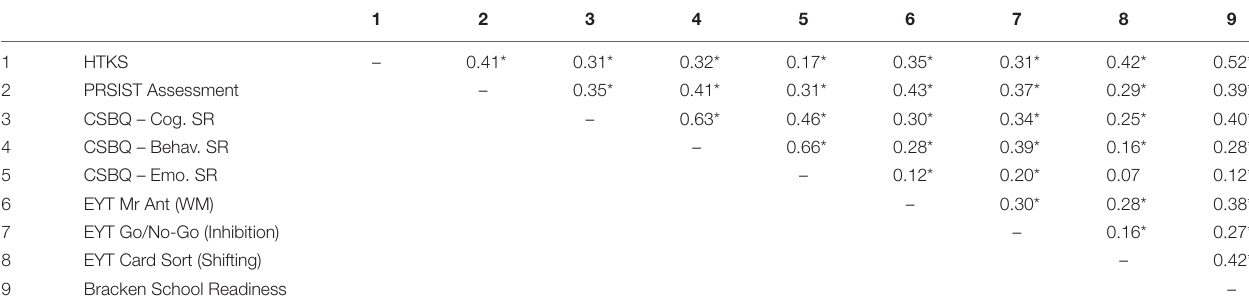
TABLE 2 | Correlations between outcome measures at